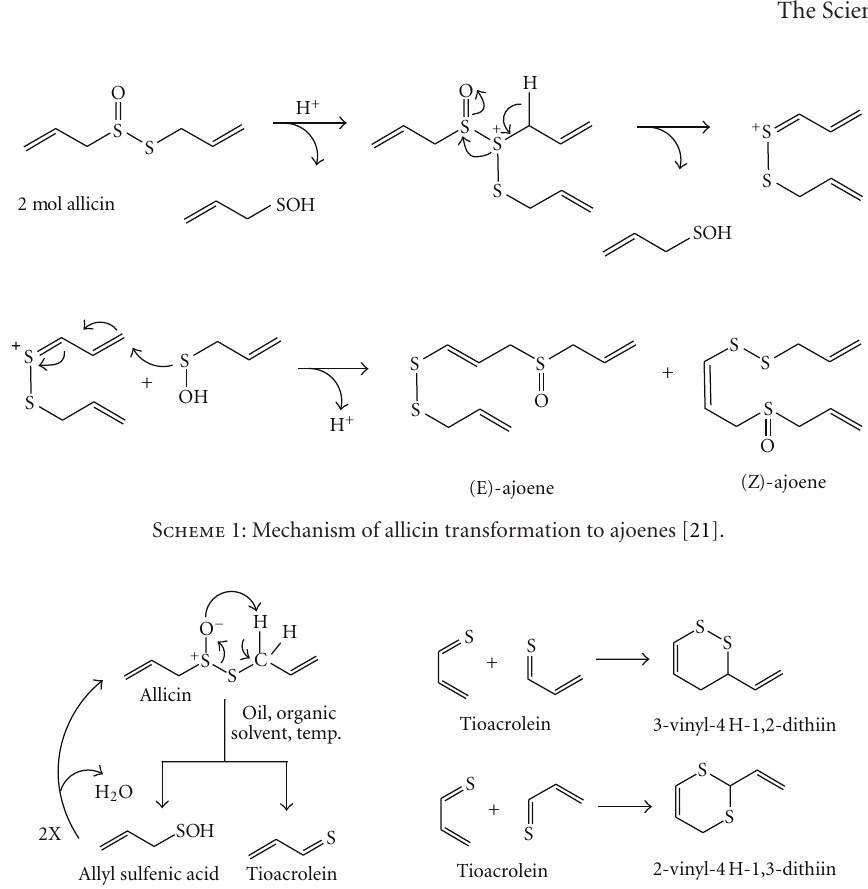
Scheme 2: Transformation of allicin in oil and organic nonpolar solvents